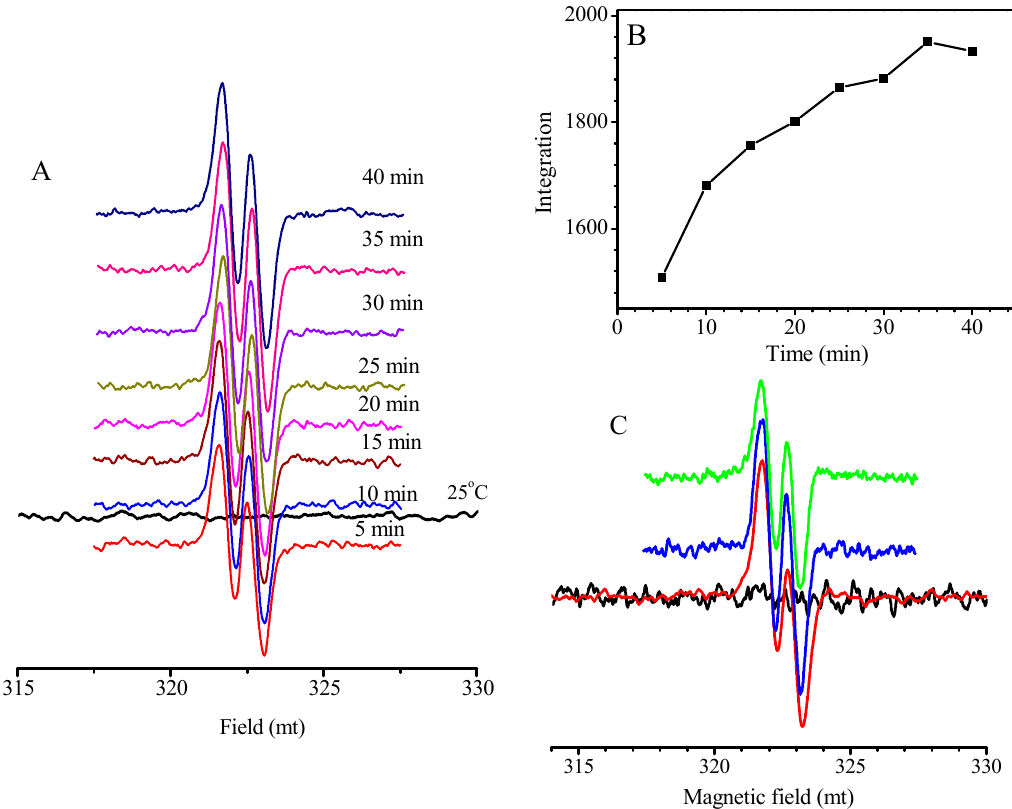
Figure 7. Electron paramagnetic resonance (EPR) spectra of the chain radicals produced at different reaction time ( A ) and relationship of the integration of EPR signals with the reaction time ( B ) for the polymerization with feed molar ratio of MMA/TPPT/AIBN = 10/2/1 at 70 °C; ( C ) EPR spectra of the radicals formed in the reaction of TPPT with AIBN (molar ratio of TPPT/AIBN = 2/1) at 70 °C for different reaction time.